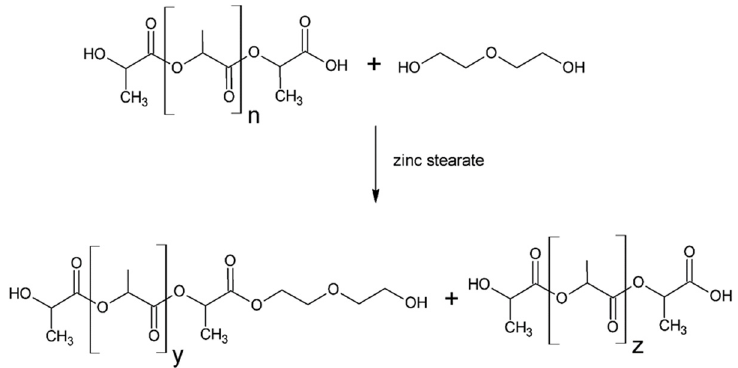
Figure 14. Transesterification reaction of PLA waste (n = y + z).